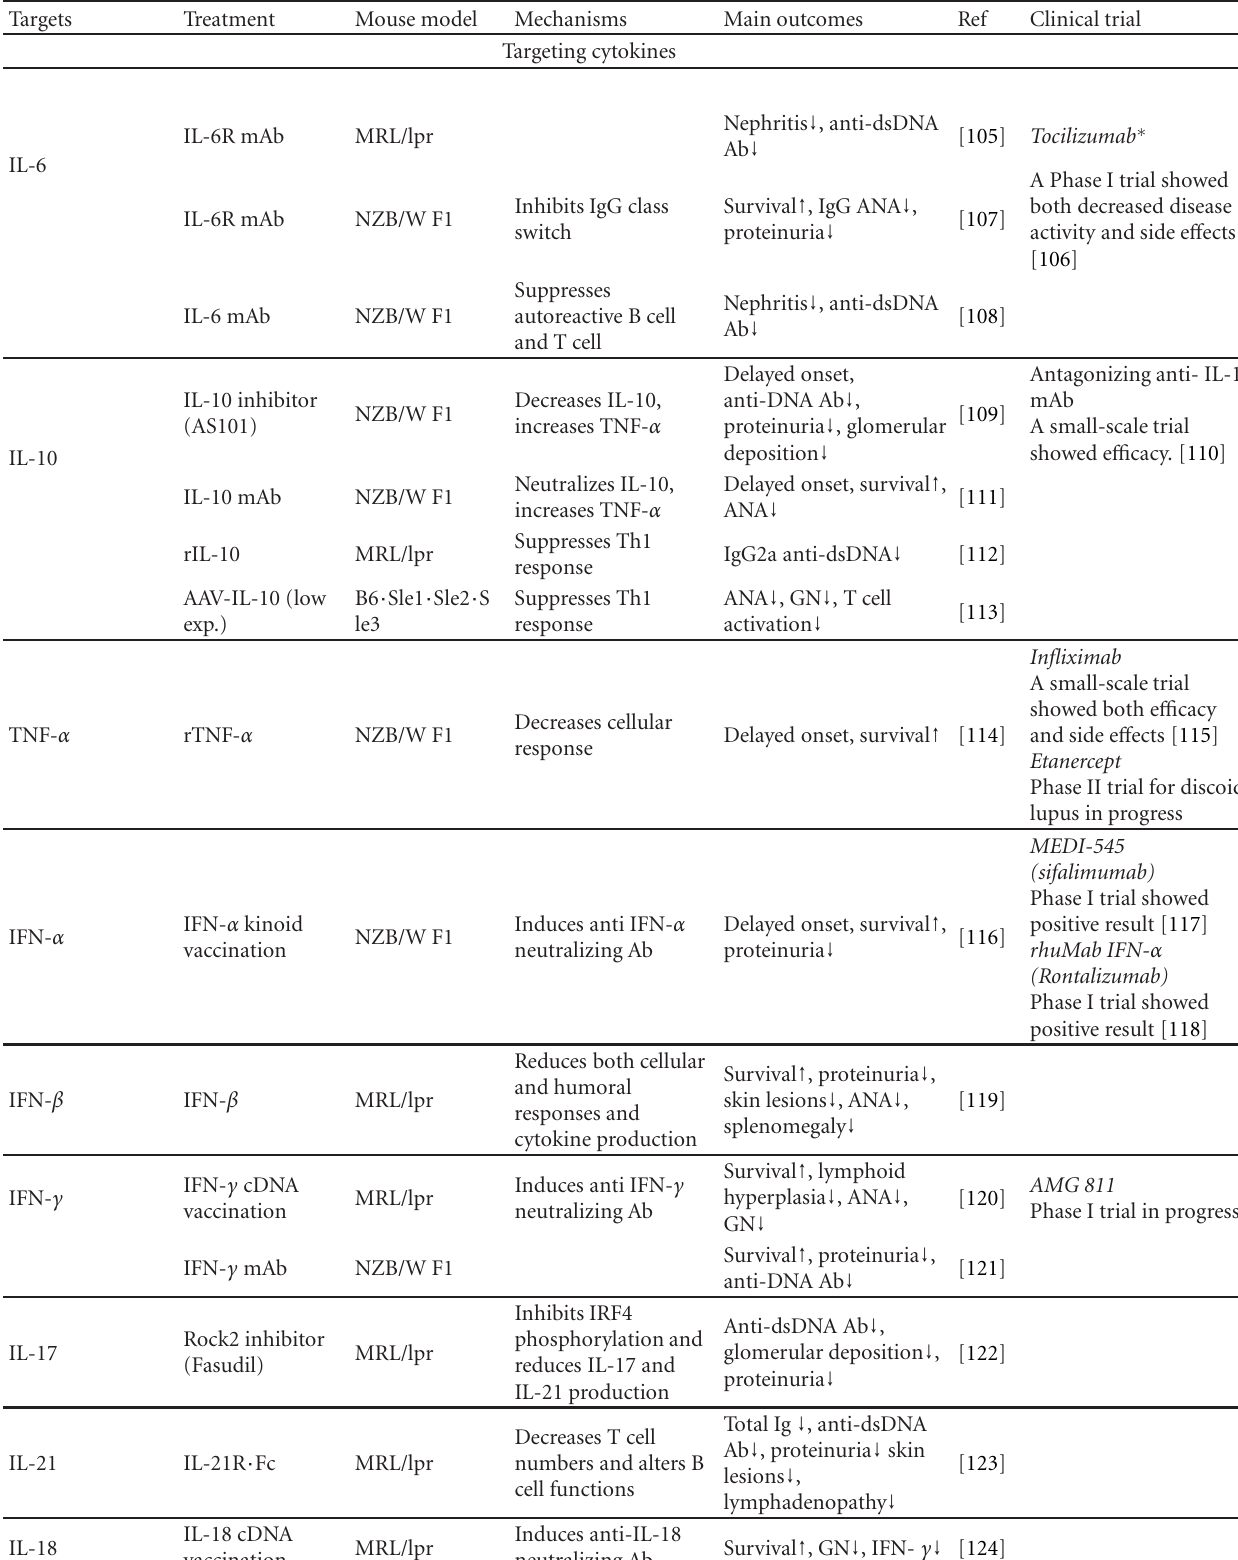
Table 1: Summary of treatments tested in mouse models of lupus, their targets, proposed mechanisms, outcomes in the mouse, and follow up in clinical